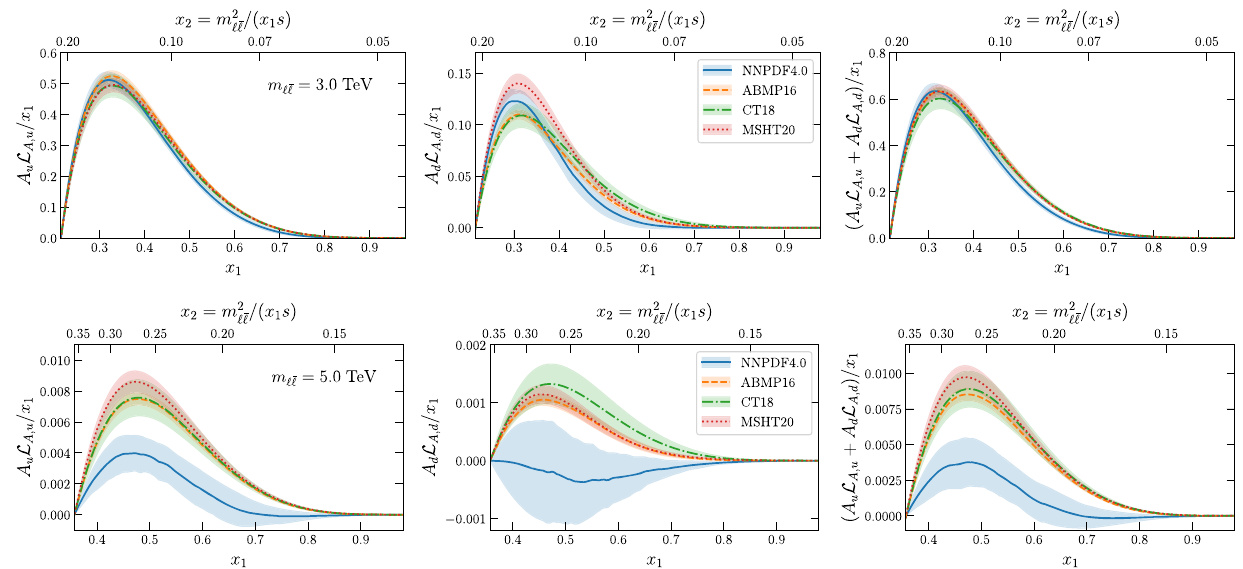
Fig. 13 The antisymmetric parton luminosities L A , q ( x 1 , m (cid:2) ¯ (cid:2) ) for the NNPDF4.0, ABMP16, CT18, and MSHT20 NNLO PDF sets for dilep- ton invariant masses of m (cid:2) ¯ (cid:2) = 3 TeV (top) and m (cid:2) ¯ (cid:2) = 5 TeV (bottom).